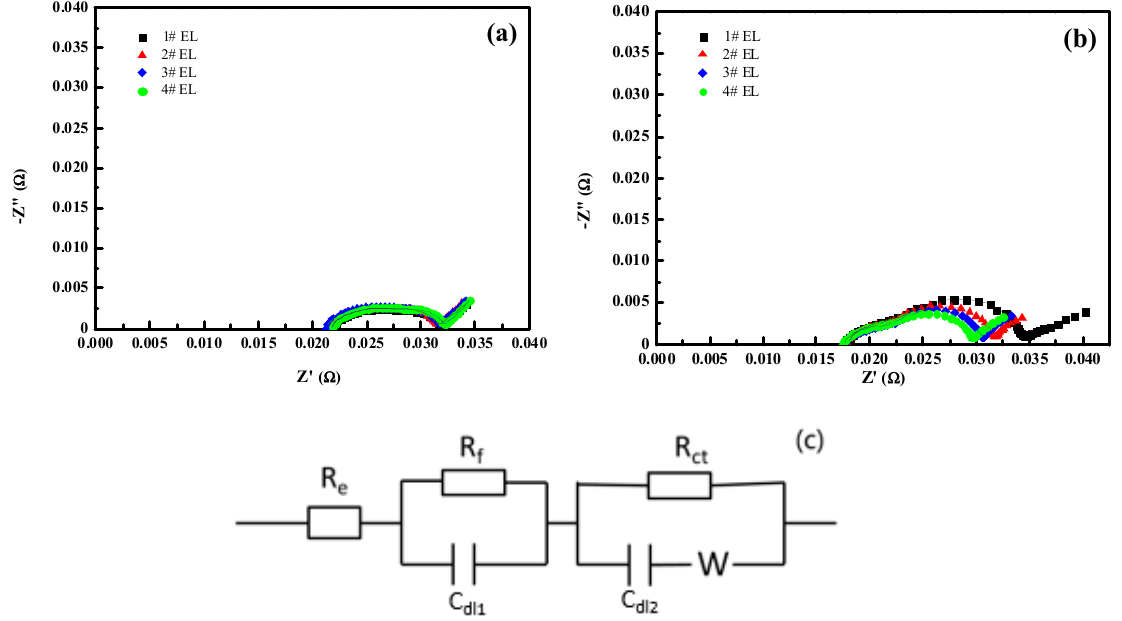
Figure 5. Representative EIS Nyquist plots and fitting curves of the two half-cells prepared with different electrolyte models (#1–#4 EL) after one cycle at 0.2 C: ( a ) graphite/Li; ( b ) LiCoO 2 /Li; ( c ) equivalent circuit model Table 3. The EIS fitting data of the coin half-cells.